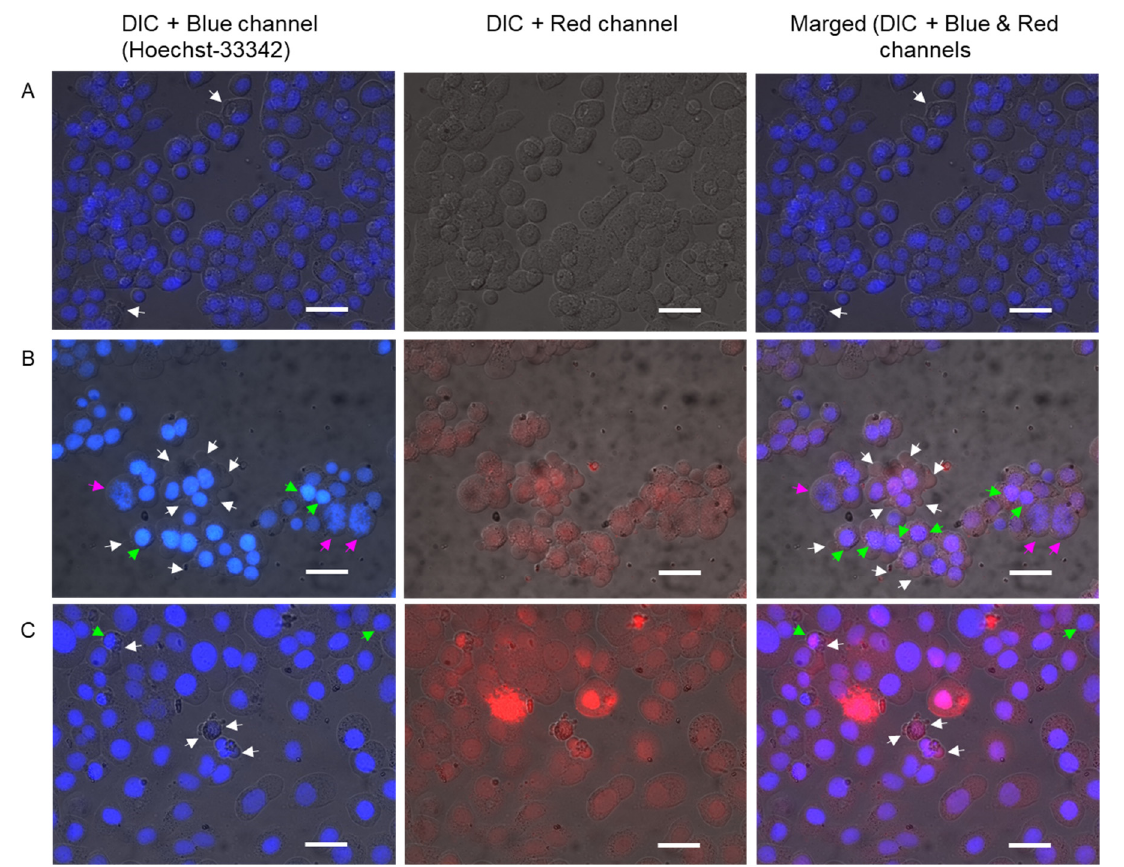
Figure 7. Photomicrographs of KB3-1 cells analyzed through Hoechst 33342 staining following 24 h exposure to studied compounds: ( А )–control (untreated) cells; ( В )–cells treated with 3.6 (1 µ М ); ( С )– cells treated with doxorubicin (1 µ М ). Bar equals 20 µm.